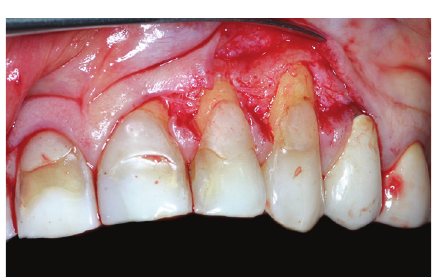
Figure 2: Intraoral clinical aspect.